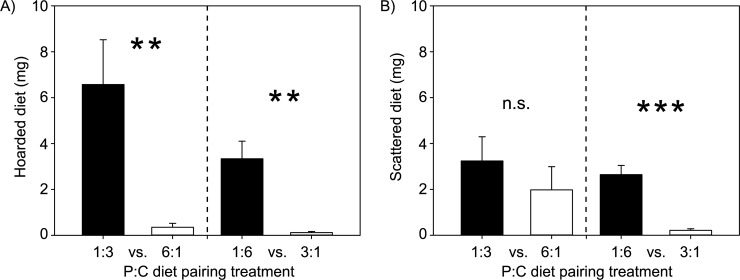
Post-harvest diet processing (± SE) after 12 days in the 2-D choice experiment, based on analyzing uneaten colored diet.(A) Colonies tended to preferentially hoard (retained inside the nest) carbohydrate-biased diets in both the 1:3 vs. 6:1 P:C pairing and the 1:6 vs. 3:1 P:C pairing treatments. (B) Colonies scattered diets evenly in the 1:3 vs. 6:1 P:C treatment, but scattered significantly more of the carbohydrate-biased diet in the 1:6 vs. 3:1 P:C treatment. Asterisks indicate the results of paired t-tests, testing difference within pairings between either hoarded or scattered diet (dry mass, mg), with n.s. = not significant, * p < 0.05, ** p < 0.01, *** p < 0.001).